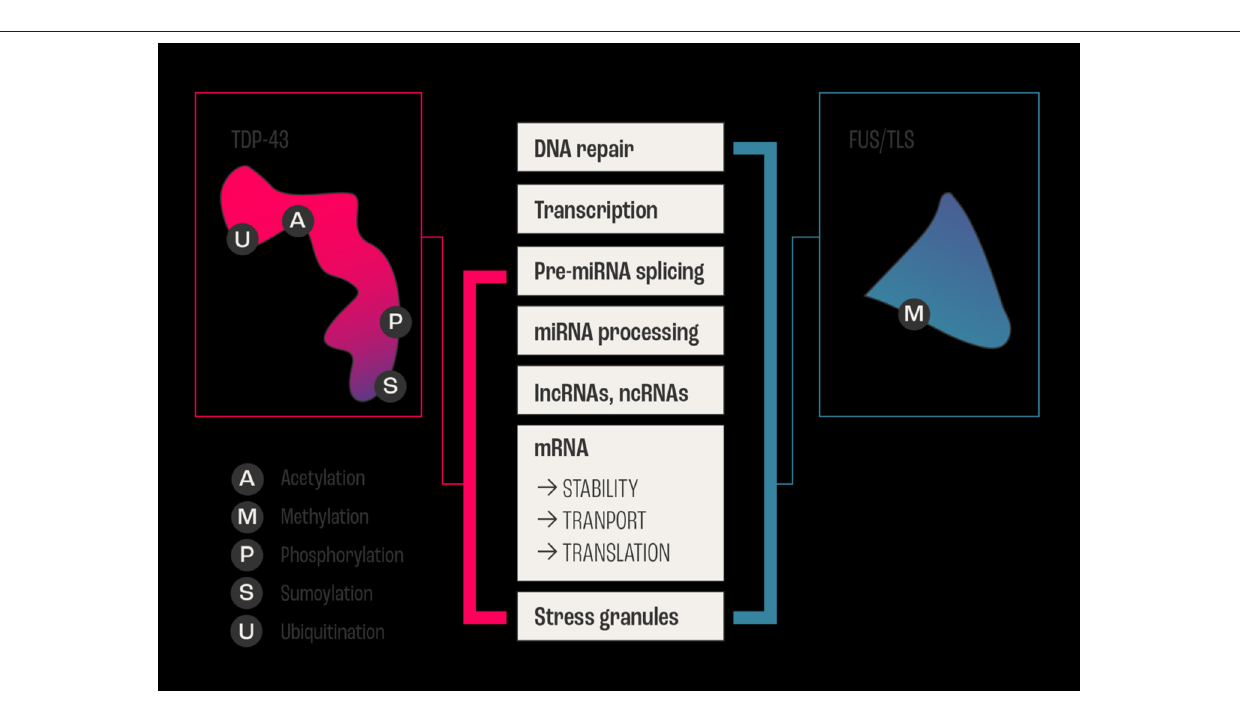
or fibrilization propensity, cytoplasmic mislocalization, stress granule dynamics dysfunction, and finally dysregulation of RNA metabolism (58). As RBPs have common or